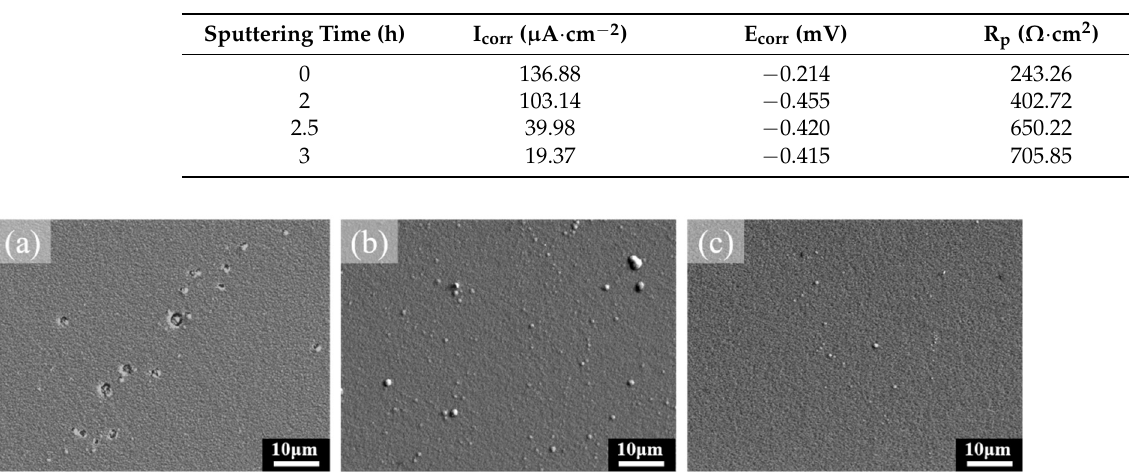
Figure 11. Surface observation of CrN thin films after 1 M H 2 SO 4 corrosion test deposited for ( a ) 2 h, ( b ) 2.5 h, and ( c ) 3